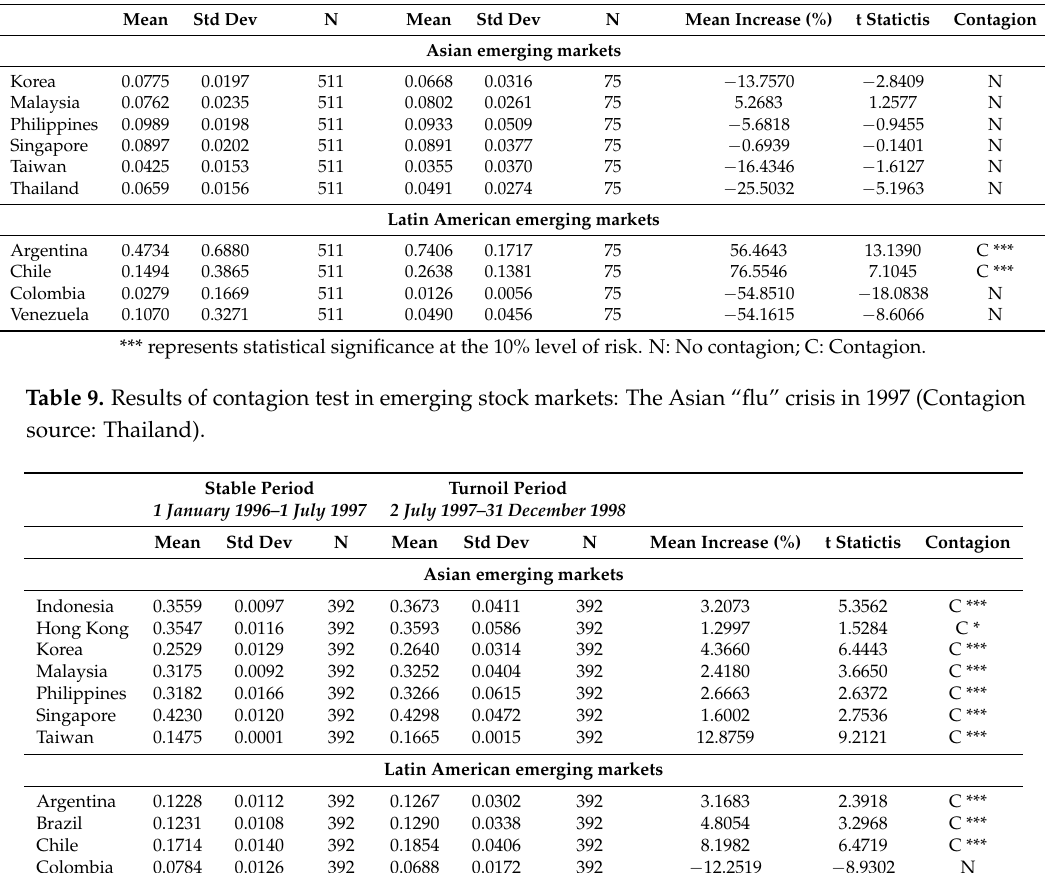
Table 8. Results of contagion test in emerging stock markets: The Mexico “Tequila” crisis in 1994. Stable Period Mean Std Dev N Mean Std Dev N Mean Increase (%) t Statictis Contagion Asian emerging markets